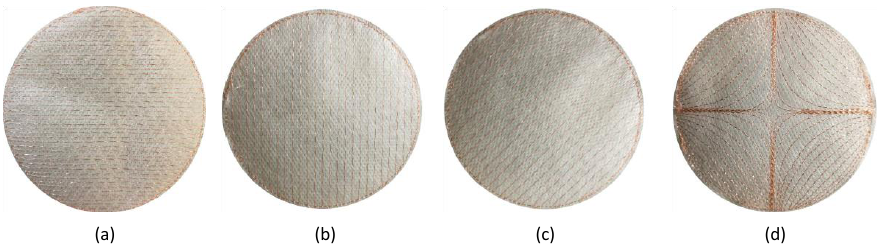
Figure 3. Embroidered patch structures with different stitch directions ( a ) horizontal pattern; ( b ) vertical pattern; ( c ) diagonal pattern; ( d ) complex pattern.